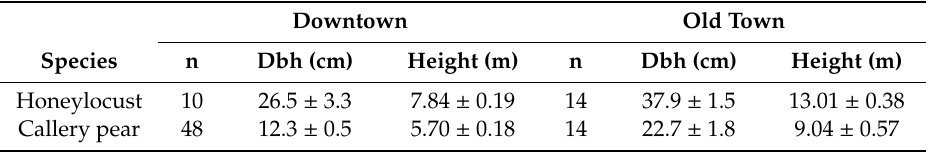
Table 1. Mean dbh (diameter at breast height) and tree heights ( ± std. err.) and sample size for honeylocust and Callery pear trees at two locations in Lansing, MI USA.